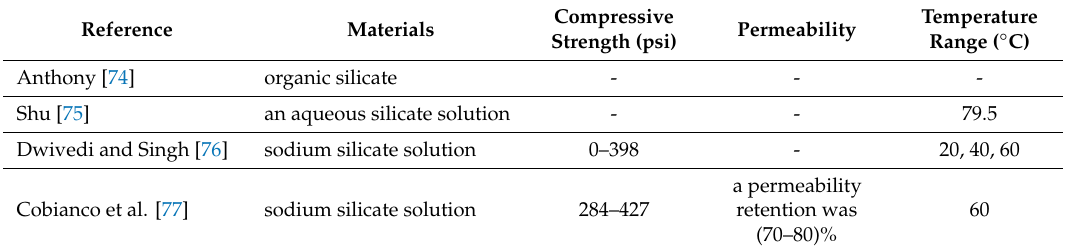
Table 9. Silicate polymer methods to consolidate sand formation.